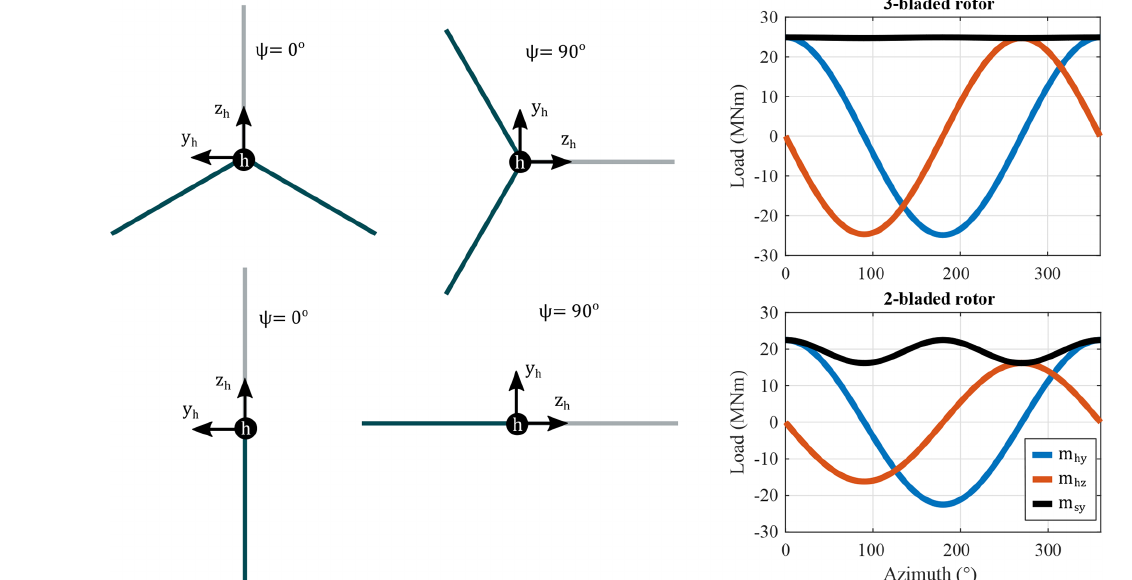
Figure 12. The hub axis ( h ) as it rotates with the rotor azimuth angle ψ for a three- and two-bladed rotor. Note that the y s axis in Fig. 5 does not rotate, while the y h axis in Fig. 12 does. An example time series of the hub loads ( m h y and m h z ) is shown to demonstrate the difference in the non-rotating main-bearing load ( m s y ) for a three-bladed (upper) and two-bladed (lower) SUMR-13B